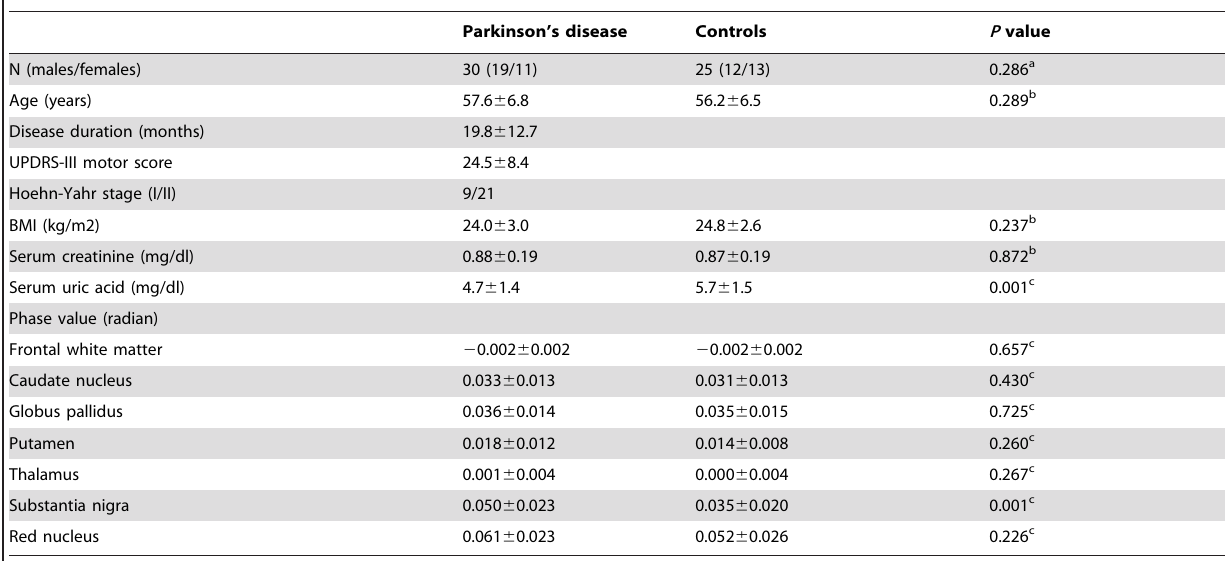
Table 1. Clinical characteristics and MRI